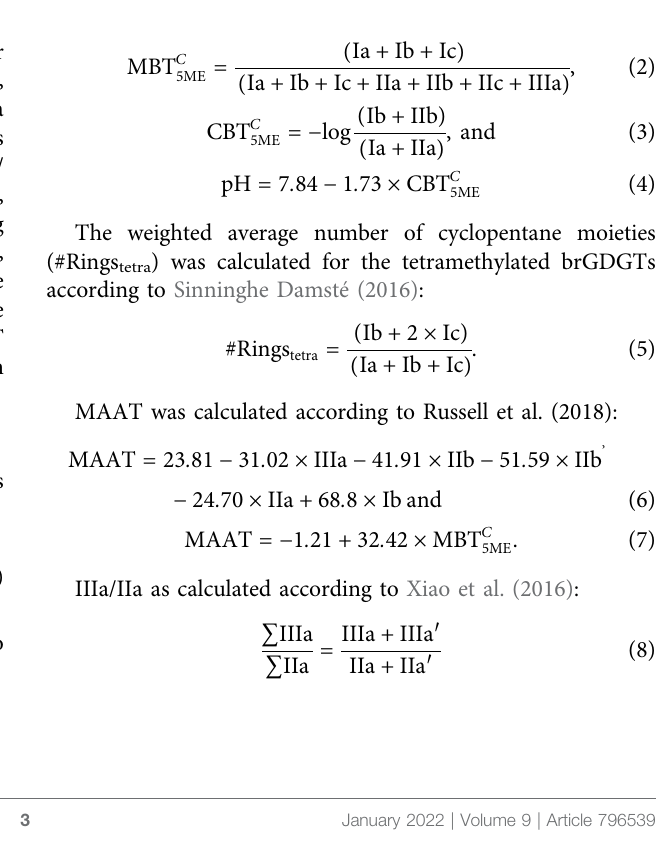
Frontiers in Earth Science |